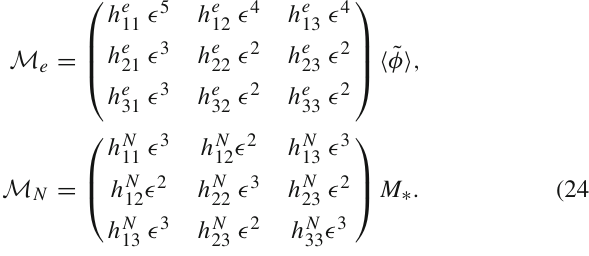
leptons which is defined by ¯ e L M e e R and the Majorana mass matrix M N for right-handed neutrinos N R